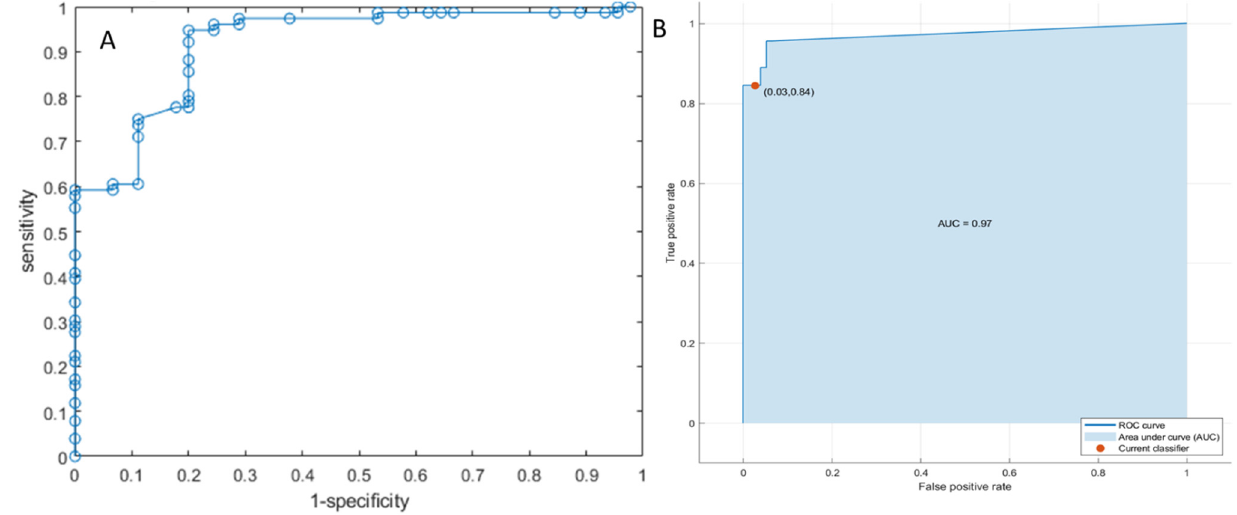
Figure 1. ROC curve of linear regression model of 15 significant features by T2w sequence in ( A ) and ROC curve of a KNN trained with the 9 significant predictors extracted from the portal phase in ( B ). All results of the dichotomy tables were statistically significant ( p -value < 0.01 at McNemar